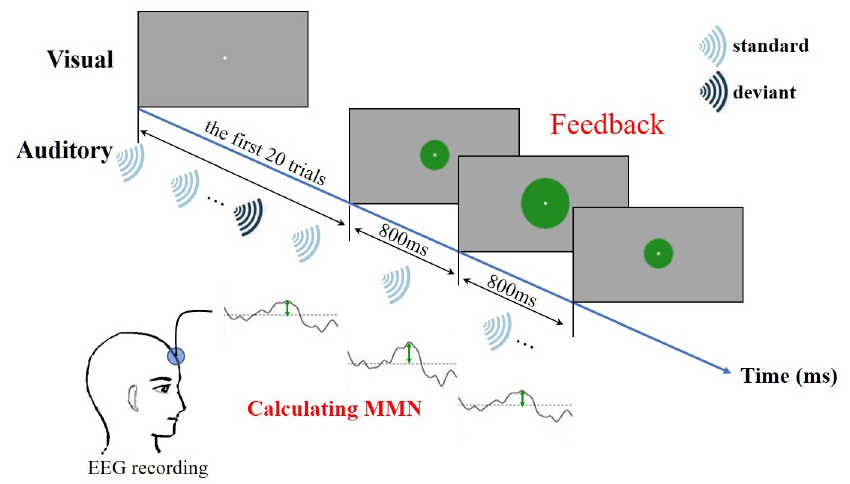
Fig 3. The procedure for neurofeedback training; ms